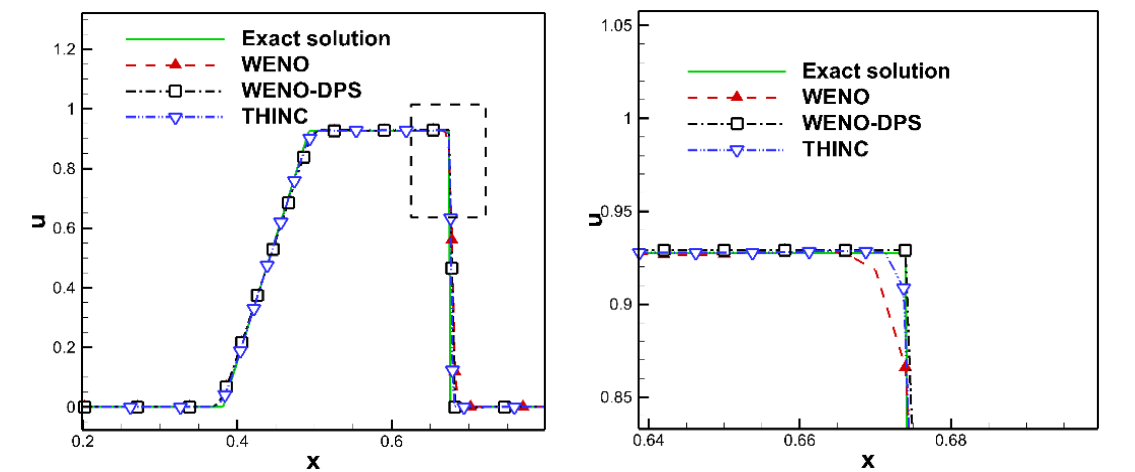
Figure 3. Velocity plot of Sod shock tube problem Figure 4. Zoomed view of velocity